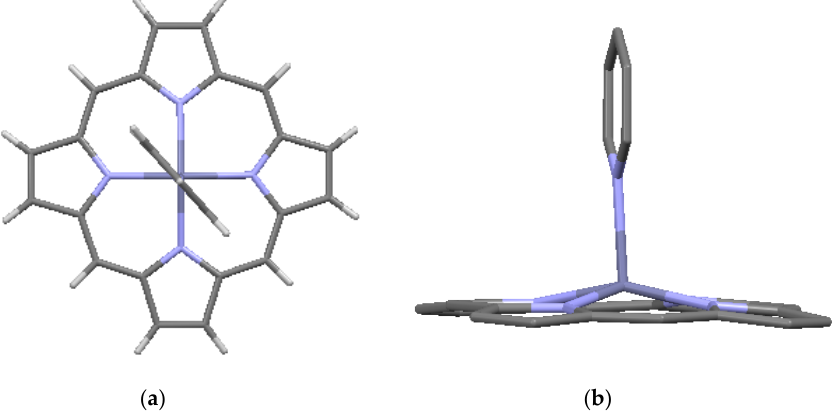
Figure 7. Zn-porphine, from data of [7,17]: ( a ) top view, with hydrogens; and ( b ) side view, without hydrogens. Dark blue = Zn.